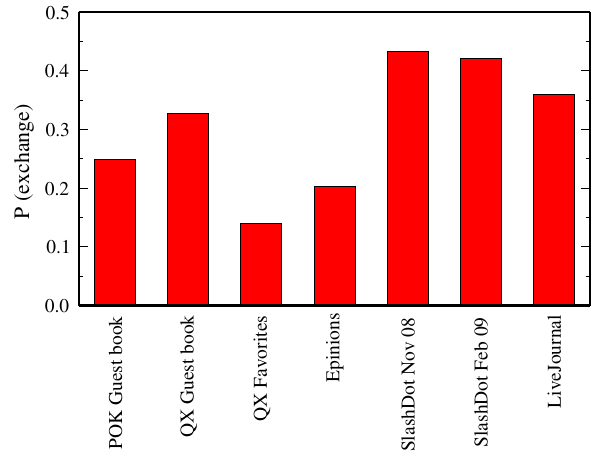
FIG. 8. Probabilistic exchange tendencies extracted from static network snapshots for several directed